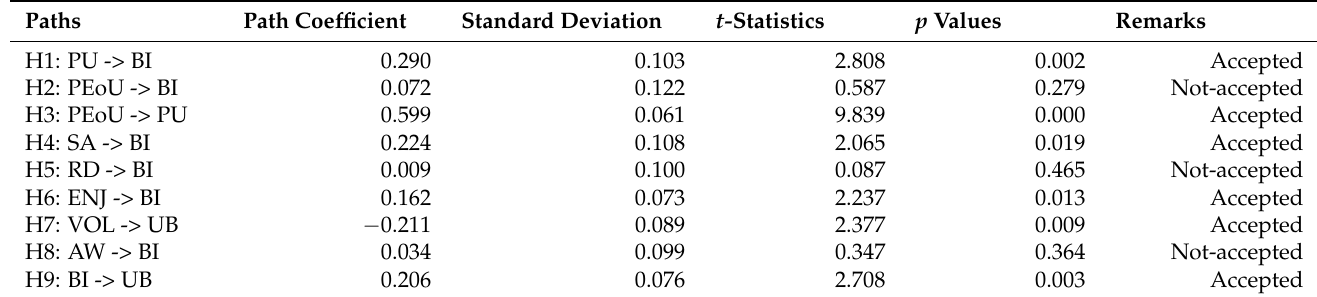
Table 6. Path coefficients and decision on hypothesis.